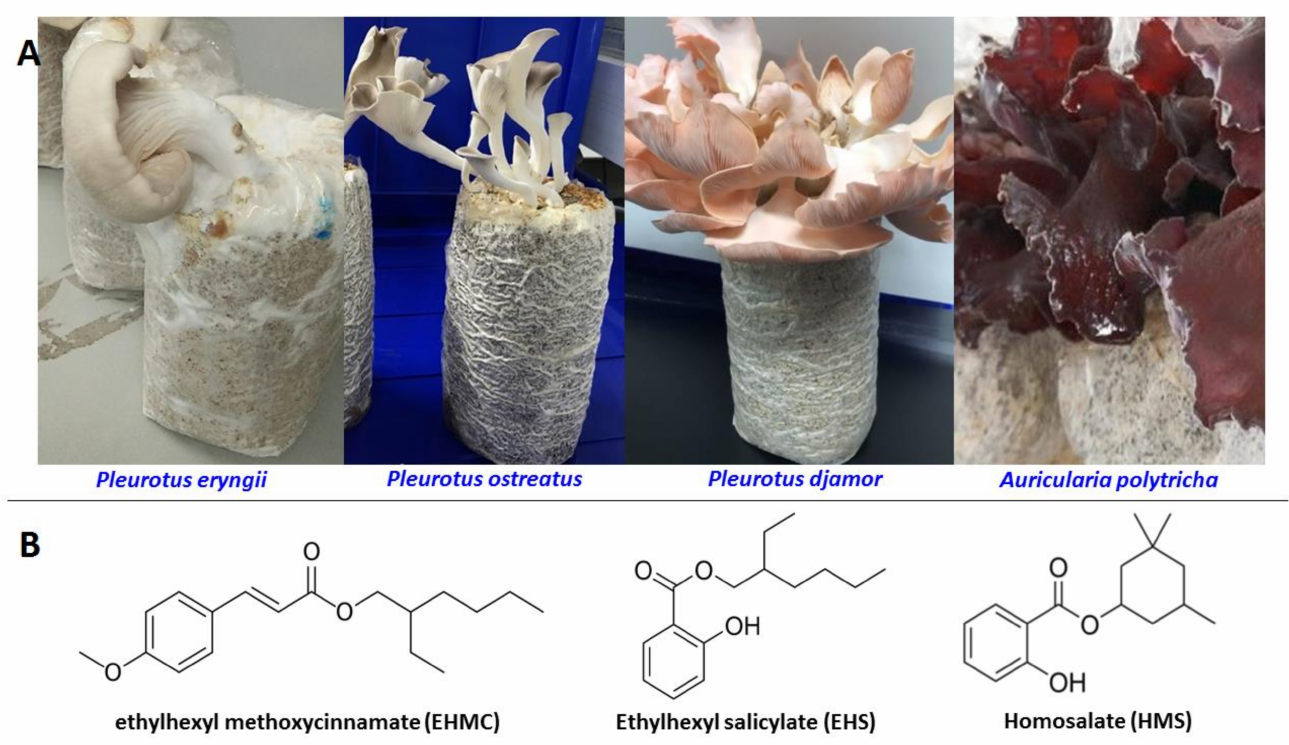
Figure 1. Spent mushroom composts (SMCs) of four mushrooms ( A ). Chemical structure formulas of the three organic UV filters used in this study ( B